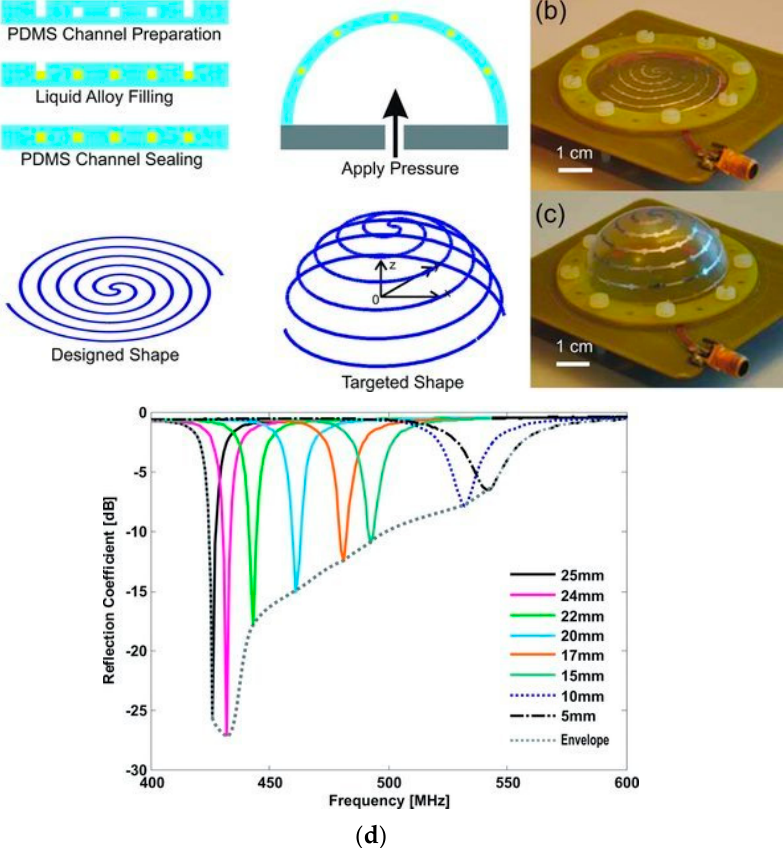
Figure 14. ( a ) Schematic illustrating ESA fabrication and operation; ( b ) implemented antenna prior and ( c ) after applied pressure; ( d ) variation in reflection co-efficient as the ESA’s dome height and corresponding frequency of operation changed [79]. Abbreviations: ESA; electrically small antenna.